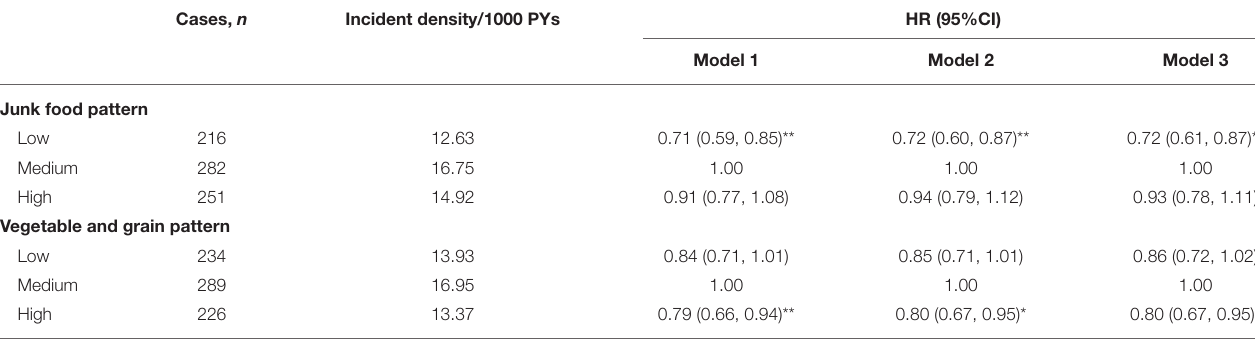
TABLE 3 | The incidence risk of type 2 diabetes (T2D) over tertiles of dietary patterns among the adult population in Southwest China. Cases,